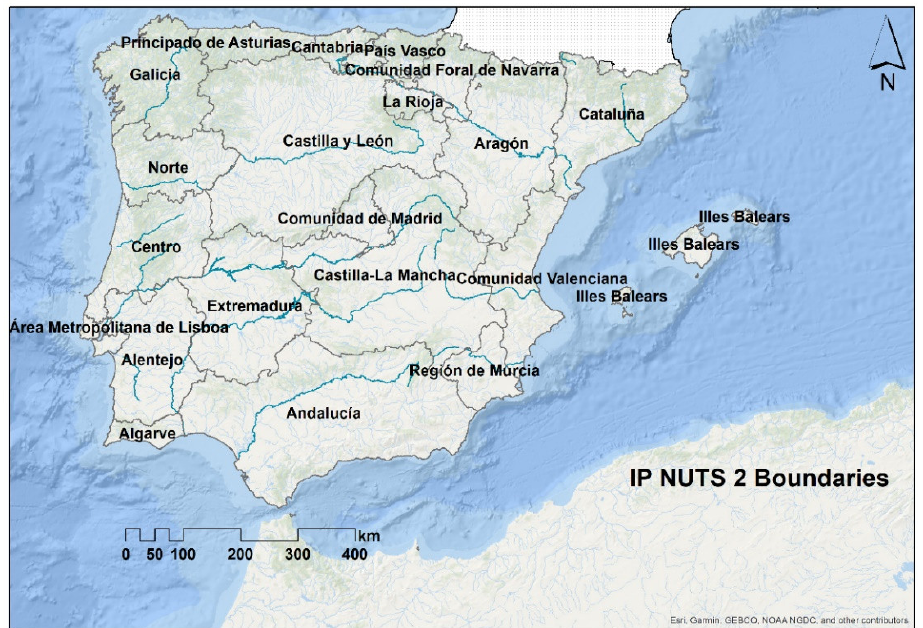
Figure 1. Iberian Peninsula (IP) study area, with the respective Nomenclature of Territorial Units for Statistics (NUTS) NUTS 2 boundaries. Table 2. WASP-Index values and their corresponding meaning